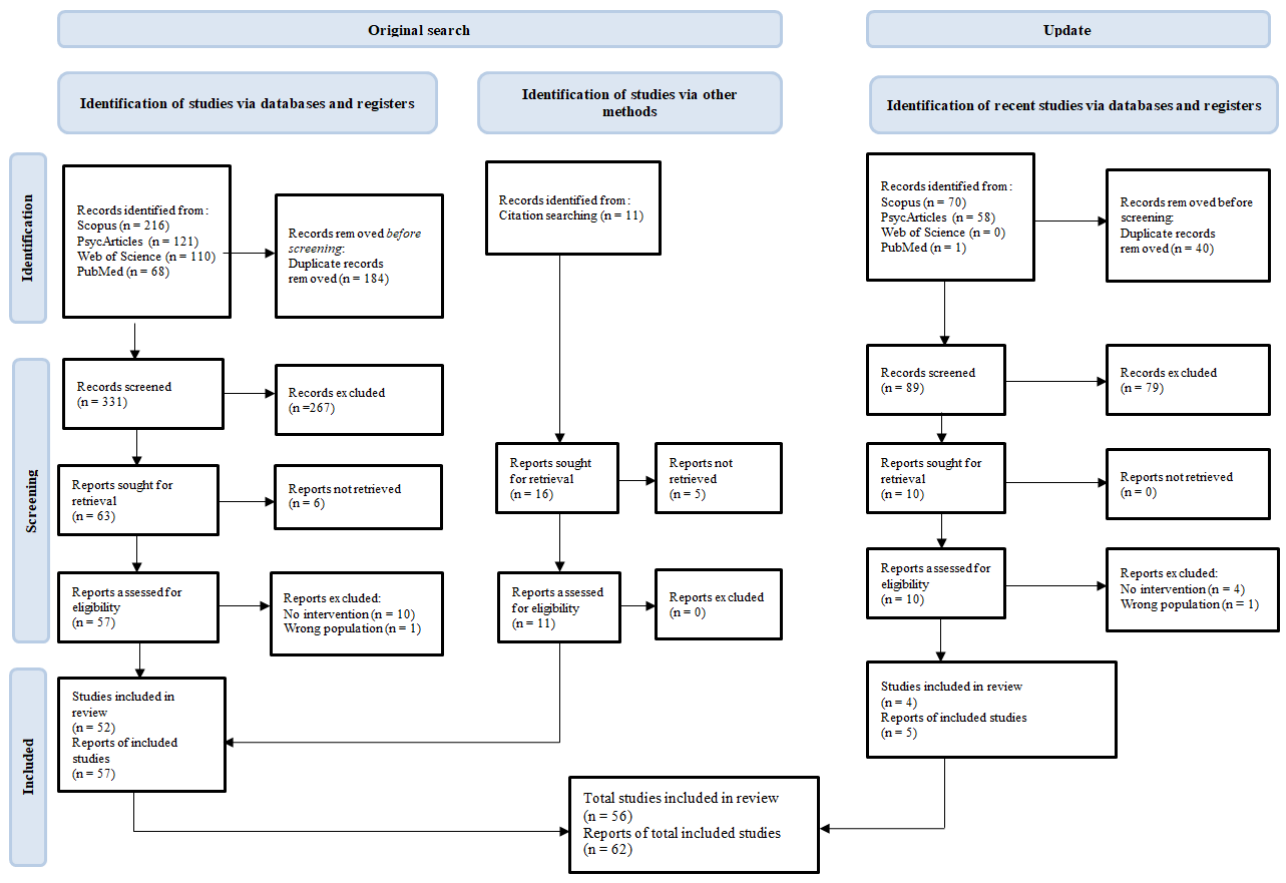
Figure 1. PRISMA flow chart.